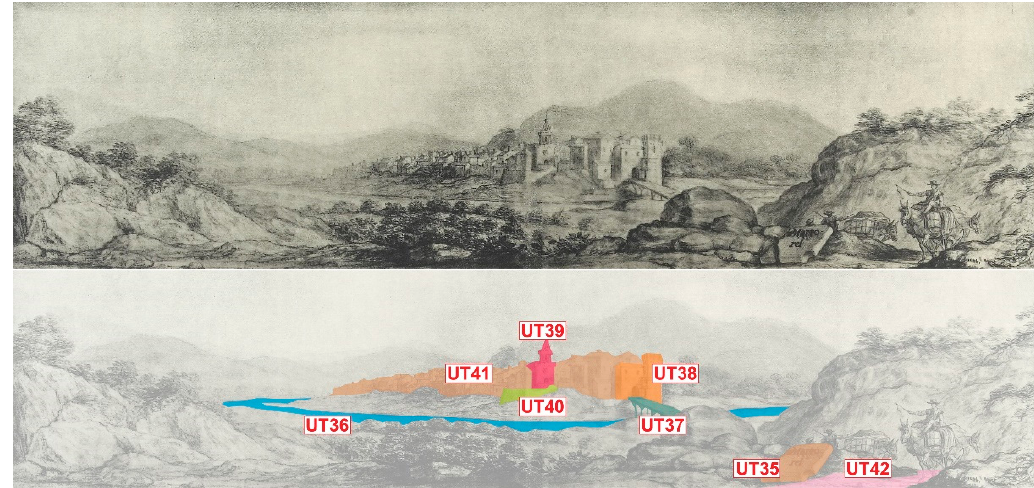
Figure A3. Pier Maria Baldi’s drawing of Martorell in the 17th Century <UT. UT are identified and labeled accordingly.